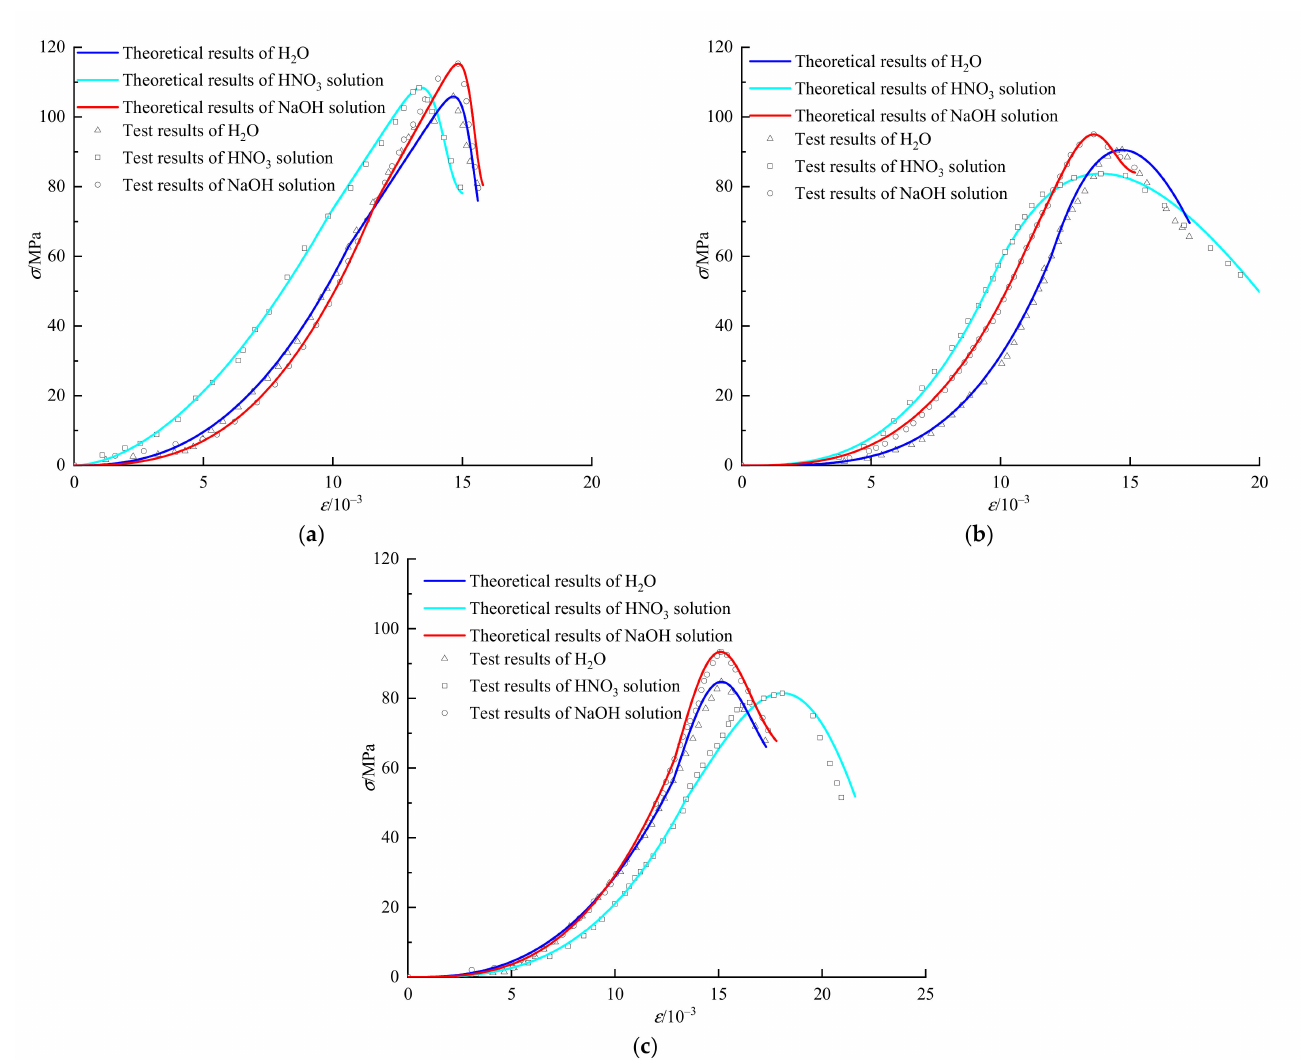
Figure 5. Comparison of the stress-strain curves and the curves of literature [21] under differ- ent chemical solutions and freeze-thaw cycles: ( a ) Freeze-thaw 0 times; ( b ) Freeze-thaw 75 times; ( c ) Freeze-thaw 100